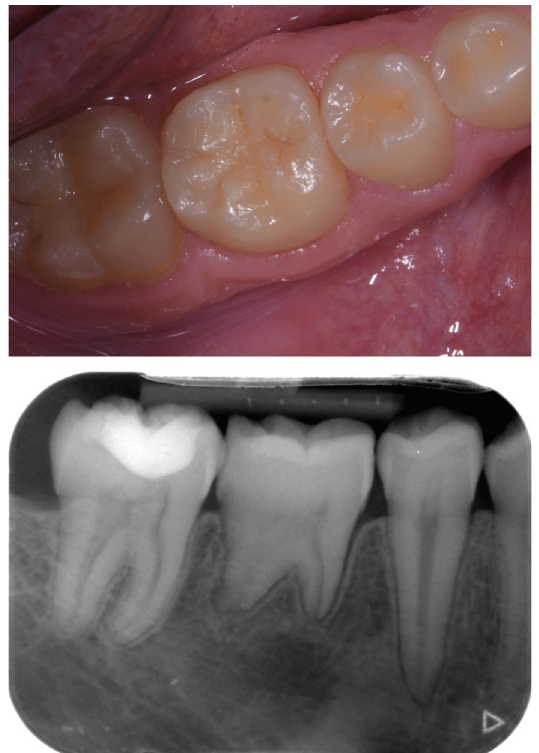
Figure 5: Tooth 46 at 1 year of